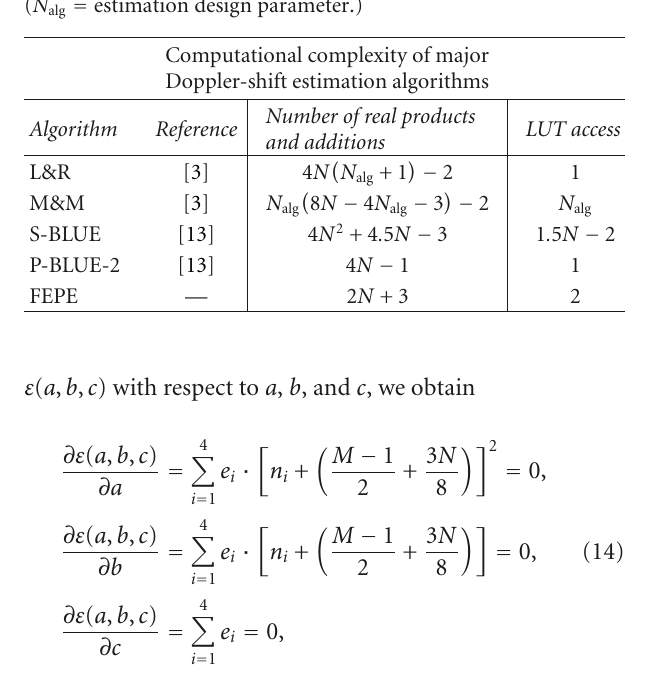
Table 1: The FEPE computational complexity comparison. ( N alg = estimation design